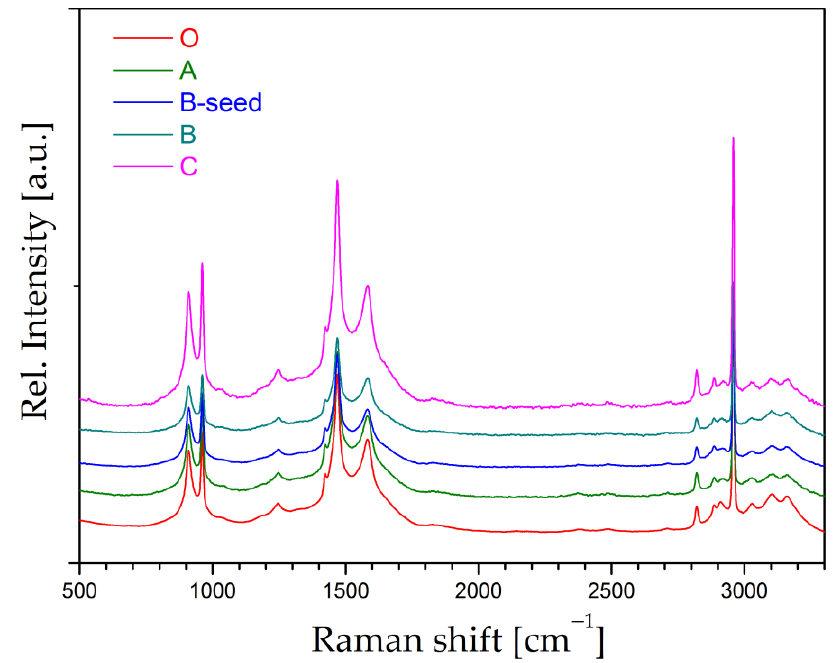
Figure 7. Normalized Raman spectra at room temperature (RT) of the hybrid perovskite crystals grown in γ -butyrolactone (GBL): crystal O, without additive; crystal A nucleated and grown with acetic acid; crystal B nucleated and grown with formic acid; crystal B seed nucleated with of acetic acid and grown in the presence of formic acid; crystal C nucleated and grown with trifluoroacetic acid.